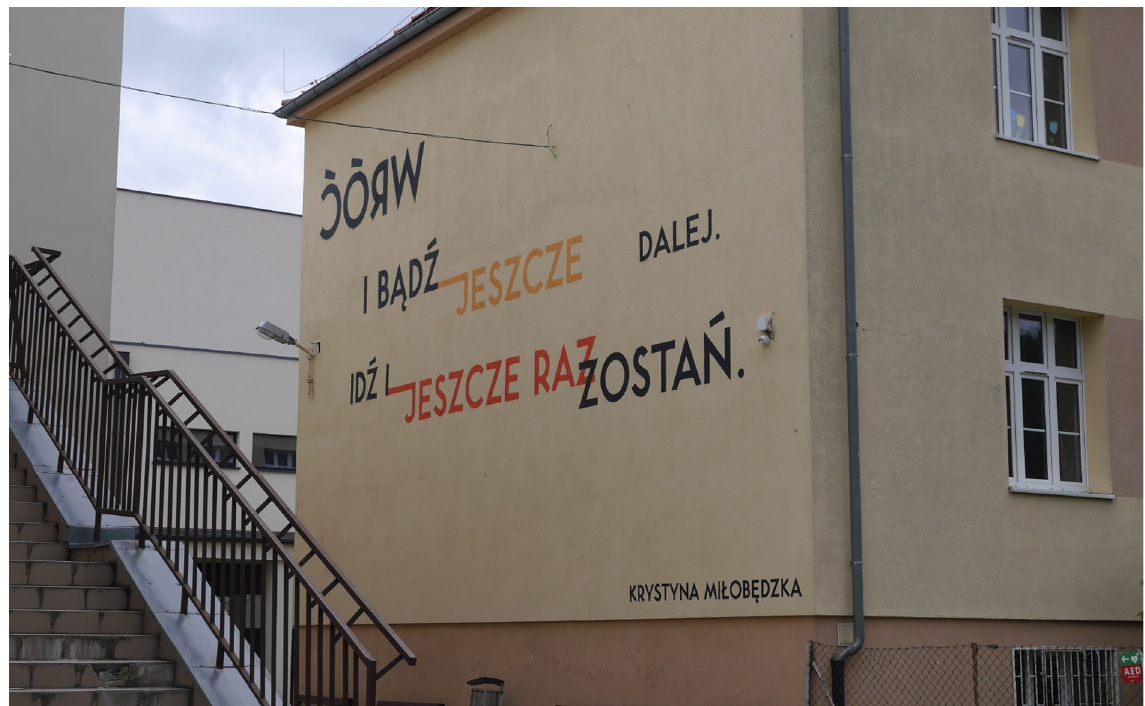
Figure 10. © photography by Pawe ł J ę drzejczak. Mural of a poem by Krystyna Mi ł ob ę dzka, jestem do znikania (I am to disappear) in Lodowa street in Pozna ń , made in a frame of project by Joanna Pa ń czak and Tomasza Genowa.